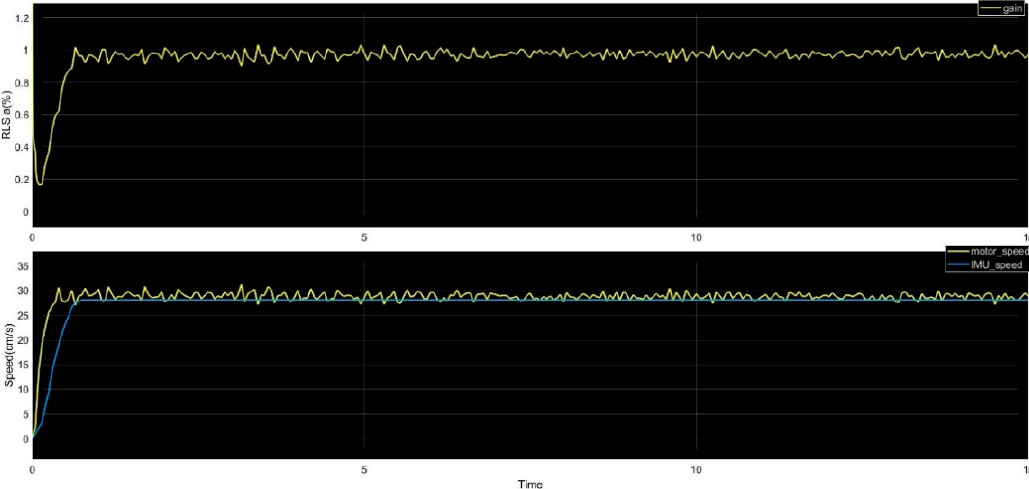
Figure 7. Estimated value by RLS method, motor speeds, and the vehicle speed of the second motor.